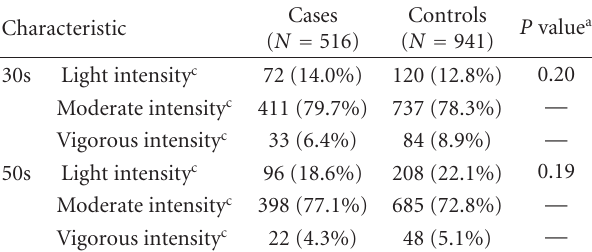
Table 1: Characteristics of the Kentucky colon cancer genetic epidemiology study postmenopausal